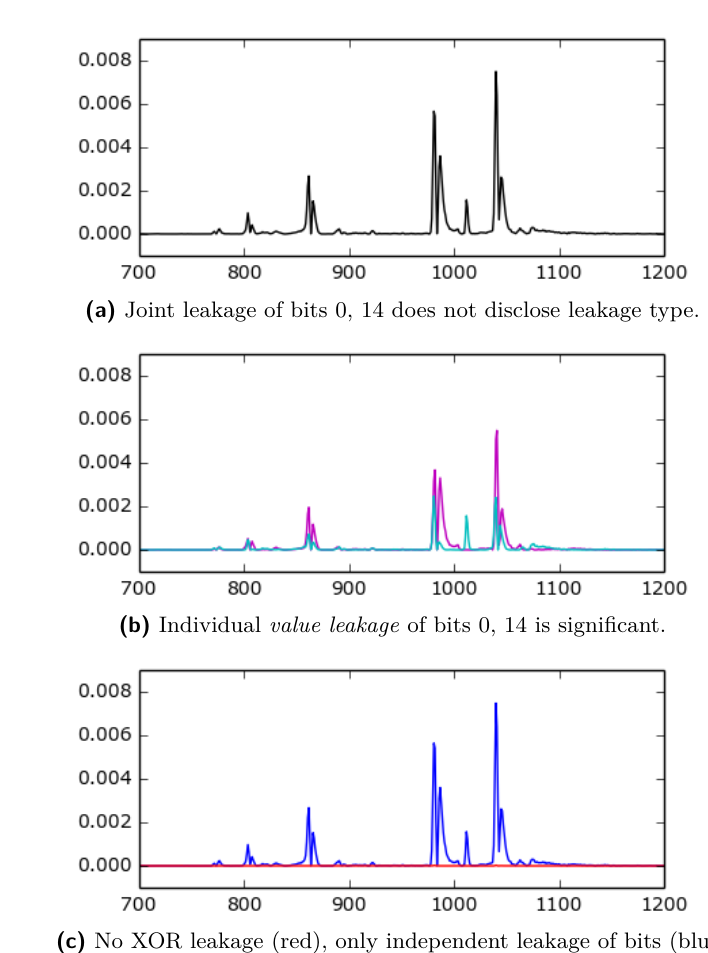
Figure 22: SNR (y-axis) for the bit pair 0,14 during the time period, where key-dependent leakage was observed (x-axis, samples recorded at 2.5 GS/s). The joint leakage can be explained entirely by the value leakage of the bits. There is no XOR leakage.